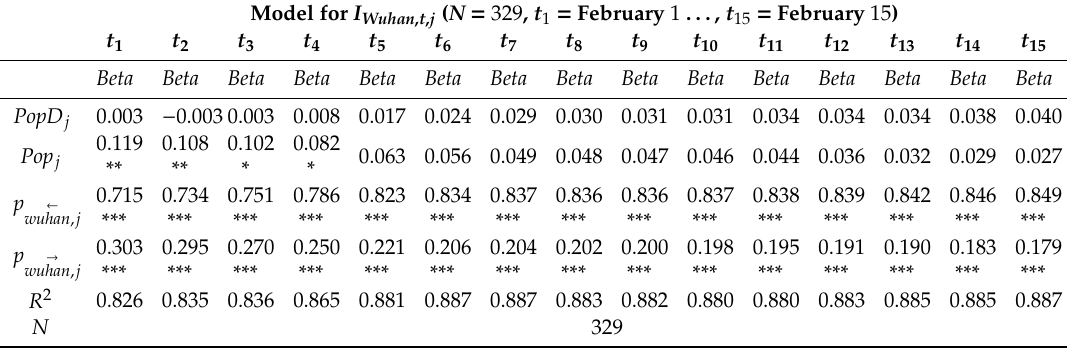
Table 2. Regression analysis of the PopD j , Pop j , p ← COVID-19 cases in prefecture-level cities ( I Wuhan , t , j ) from February 1, 2020 to February 15,